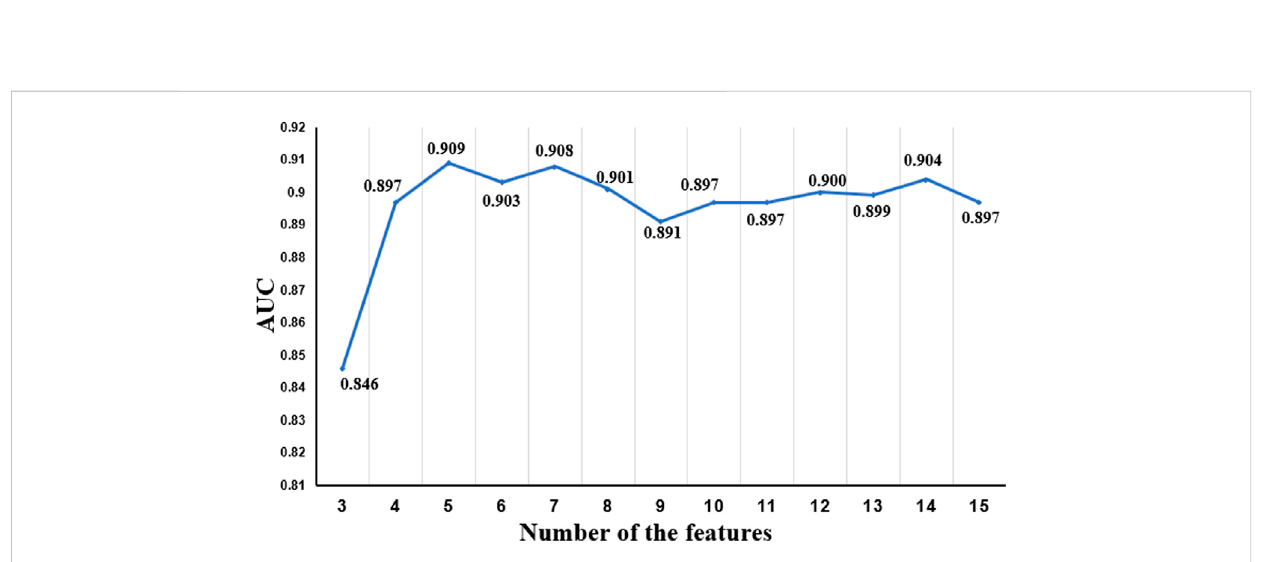
FIGURE 6 AUC values of different quantitative characteristics.